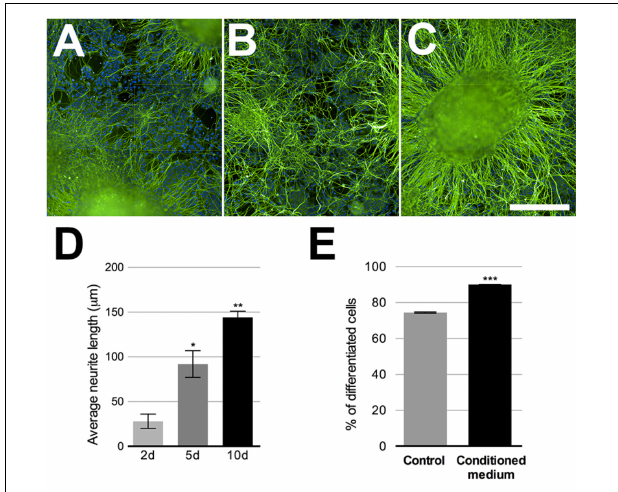
FIGURE 3 | Sensory neurons differentiation. Beta-tubulin class III (green)-stained neurons after 2, 5, or 10 days in neuronal medium conditioned with 75% HEKn medium. Nuclei were stained with DAPI. (A–C) Quantification of neurite length in PSNs was based on beta-tubulin Class III (green) immunostaining. Computer assisted image segmentation identified all neurites and measured the total length at each time point. Neurites increased by 328% in length after 5 days and 514% after 10 days in culture with 75% HEKn CM (D) . One-way ANOVA followed by Tukey’s multiple comparison test, ∗ p < 0.05 and ∗∗ p < 0.01, n = 3 independent experiments individual experiments from three separate differentiations. Percentage of differentiated neurons was increased by HEKn-CM treatment by 17.4% after 10 days of culture, as measured by β -tubulin III-staining (E) . Unpaired t -test, ∗∗∗ p < 0.001, n = 3 individual experiments from three separate differentiations. Scale bar = 100 µ m.